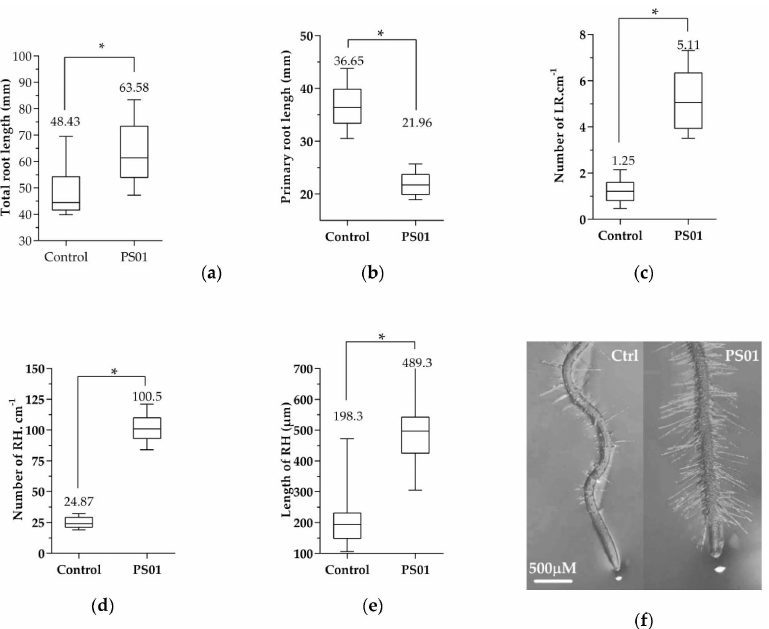
Figure 2. E ff ects of PS01 on root system architecture (RSA) of Arabidopsis . ( a ) Total root length was measured as total length of primary root and lateral roots (LR) ( n = 15); ( b ) Primary root length ( n = 15); ( c ) Density of lateral root was calculated as the number of LR divided by primary root length ( n = 15); ( d ) Root hair (RH) density expressed as the average RH number ± SD in the root segment located 0.5 cm above the root tip ( n = 15); ( e ) Average RH length ± SD ( n = 75); ( f ) Root tips of the non-inoculated (left) and inoculated (right) seedlings. Data are depicted as boxplots representing the range of values, the exclusive median. Asterisks indicate significant di ff erences (Student’s t test; p < 0.05). Microorganisms 2020 , 8 , x FOR PEER REVIEW